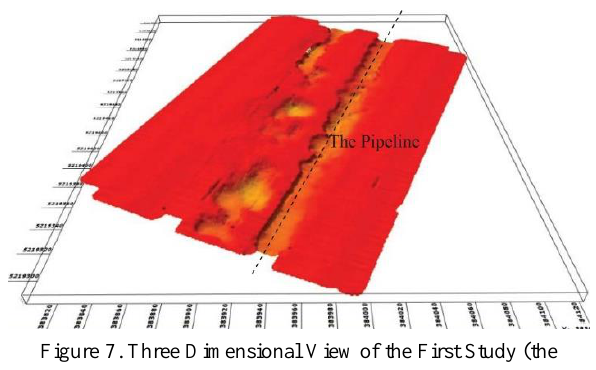
Figure 7. Three Dimensional View of the First Study (the